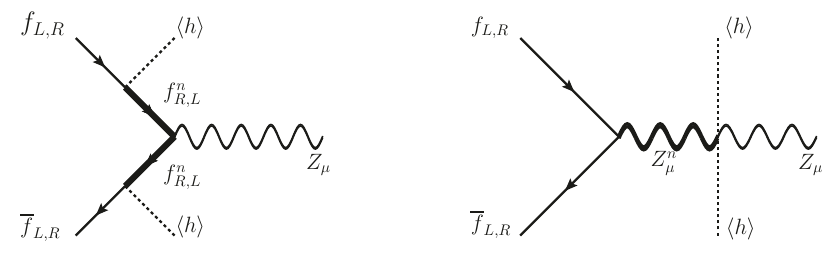
Figure 2 . Diagrams contributing to (cid:14)g f